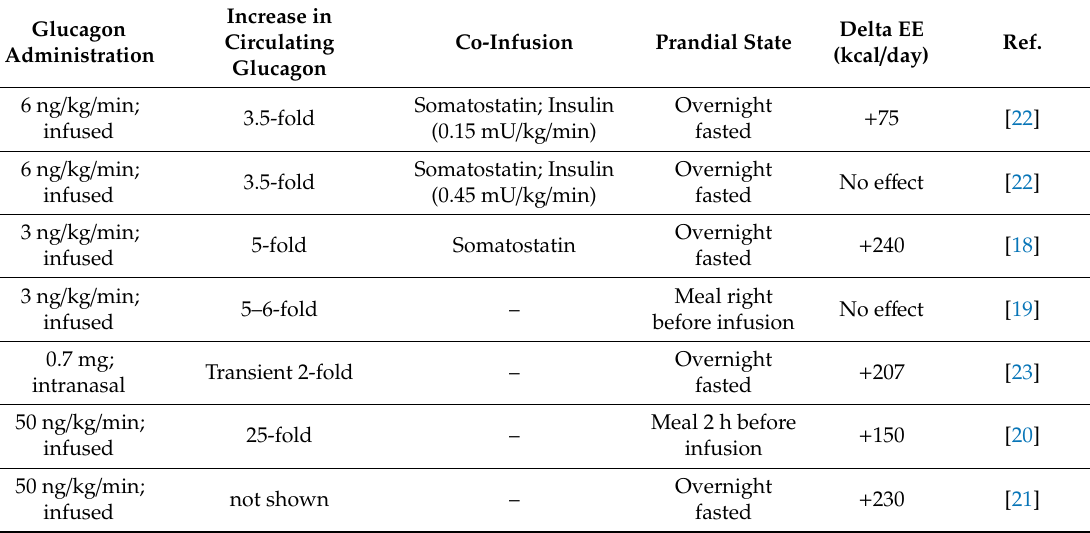
Table 1. Studies assessing glucagon’s e ff ect on energy expenditure in